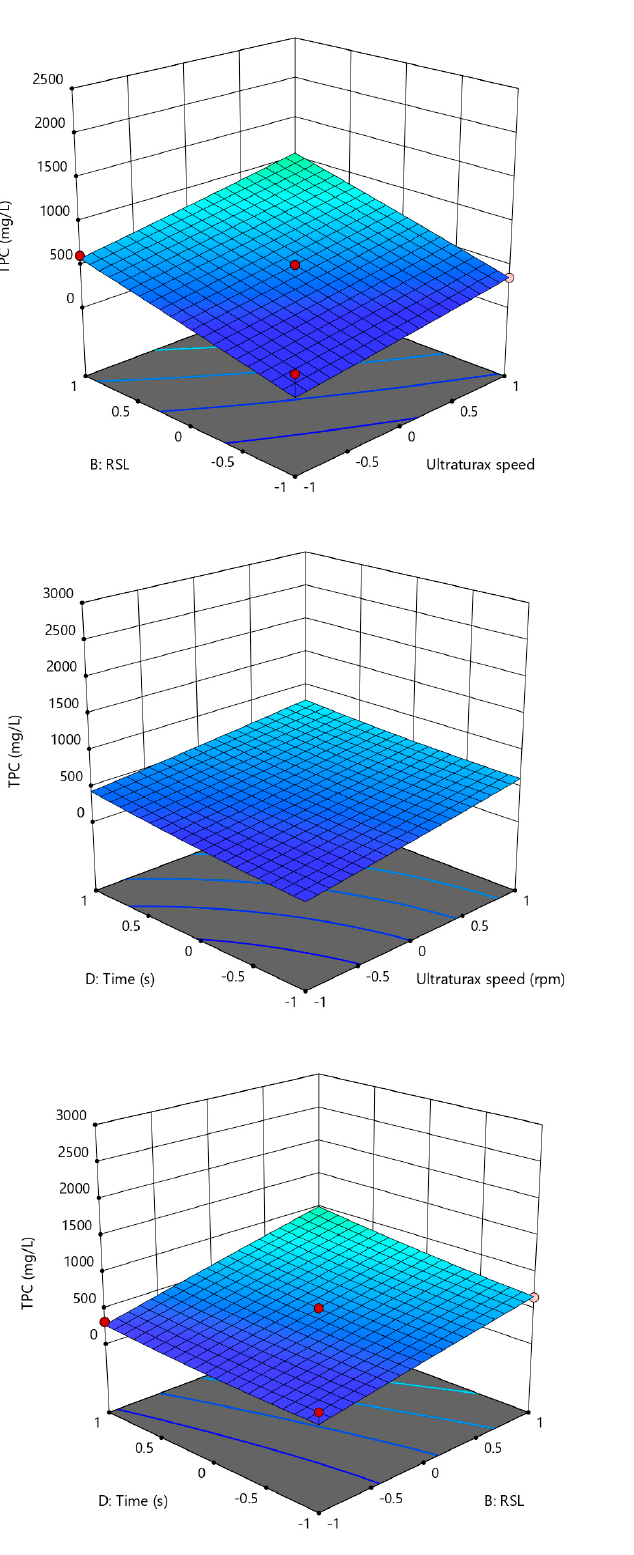
Figure 2. 3D evolution of TPC according to the Box–Benhken design. − 1 the low value of the parameter, +1 the highest value of the parameter according to data from Table 1